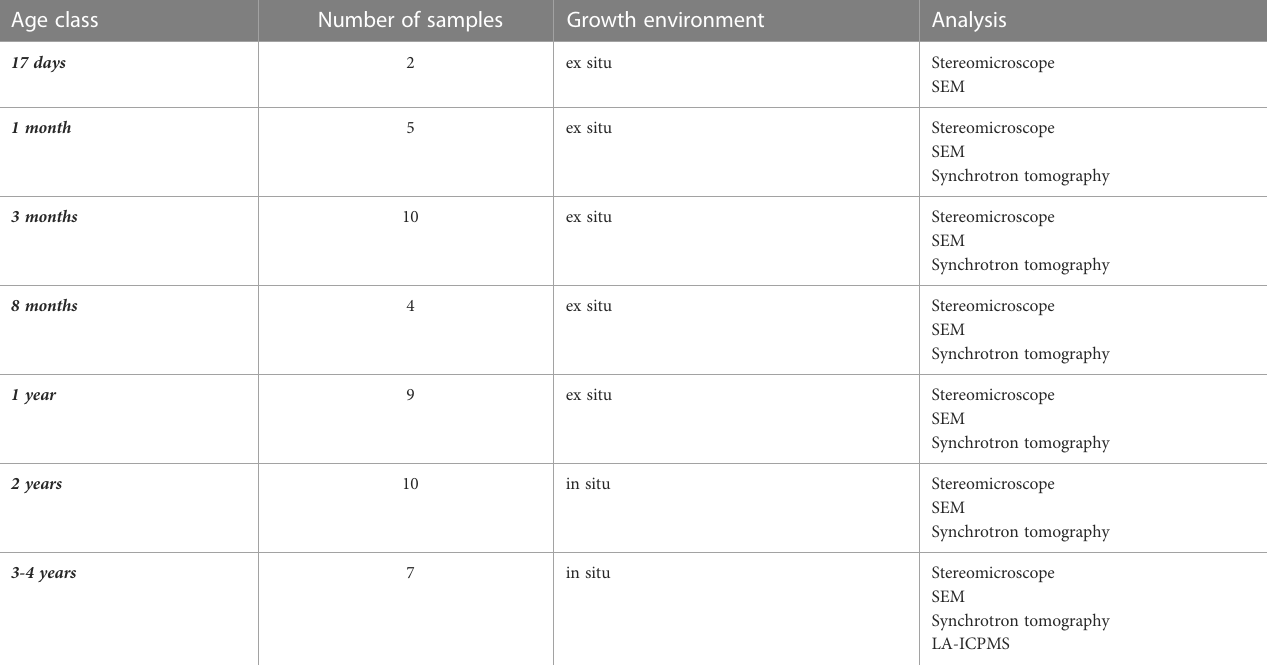
TABLE 1 List of the analyzed samples, divided into age